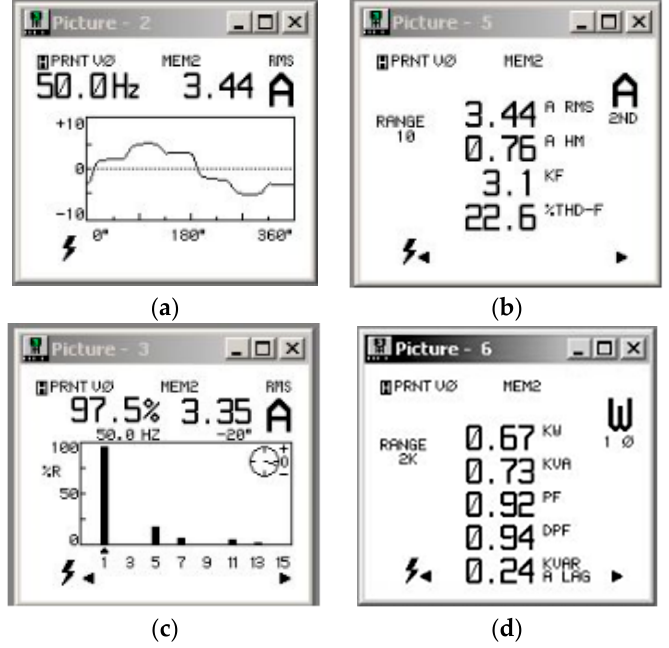
Figure 22. Experimental results for the adaptive control at reduced load on the load side, in steady state regime, provided by Fluke 41B analyzer: ( a ) waveform of the load current; ( b ) RMS value and load current THD ; ( c ) harmonic spectrum of the load current; ( d ) powers per phase and power factor.